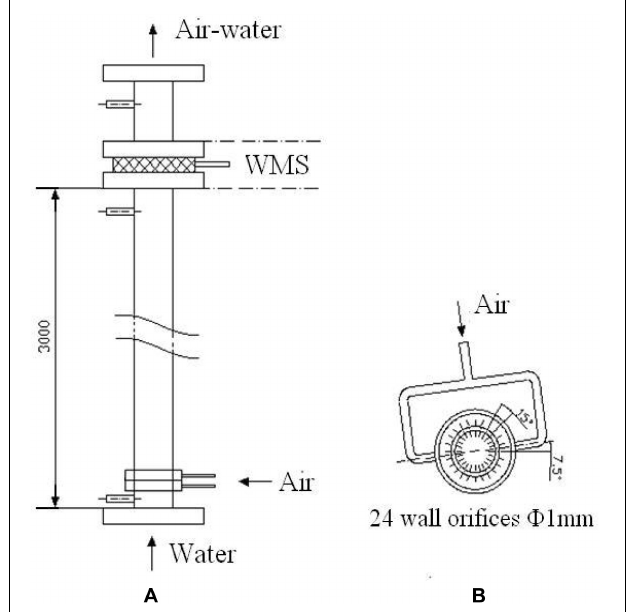
FIGURE 3 | (A) Scheme of the experiment set-up, (B) air